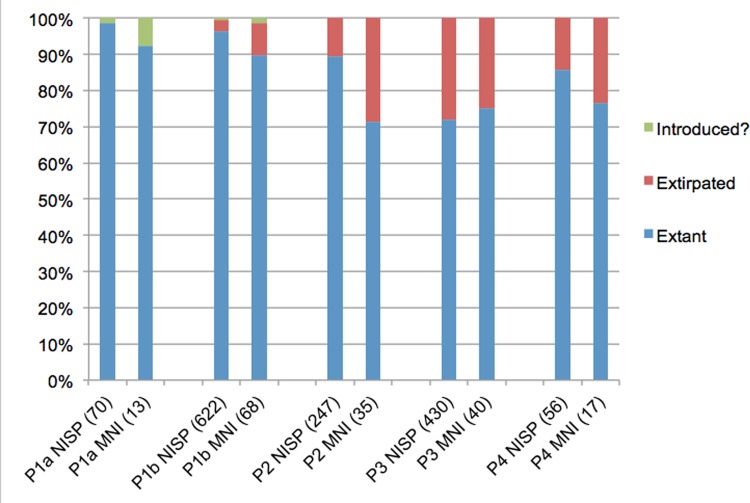
Extirpated, extant and introduced fauna in Kuumbi Cave Trench 10.Relative frequency of nonhuman mammalian fauna that are extant or extirpated on Zanzibar today. “Introduced?” are remains of possible domestic cattle; we stress the tentative nature of this identification, given the paucity of diagnostic elements and the possible persistence of similarly-sized extirpated bovids. Extirpated fauna include: zebra, steenbok, bush duiker, bushbuck, reedbuck, waterbuck, buffalo, white-tailed mongoose, hare, porcupine, and a possible Thomson’s gazelle. Microfauna and remains only identifiable to size class (e.g., “Mammal Size 2”) were excluded from this analysis. NISP, number of identified specimens; MNI, minimum number of individuals.